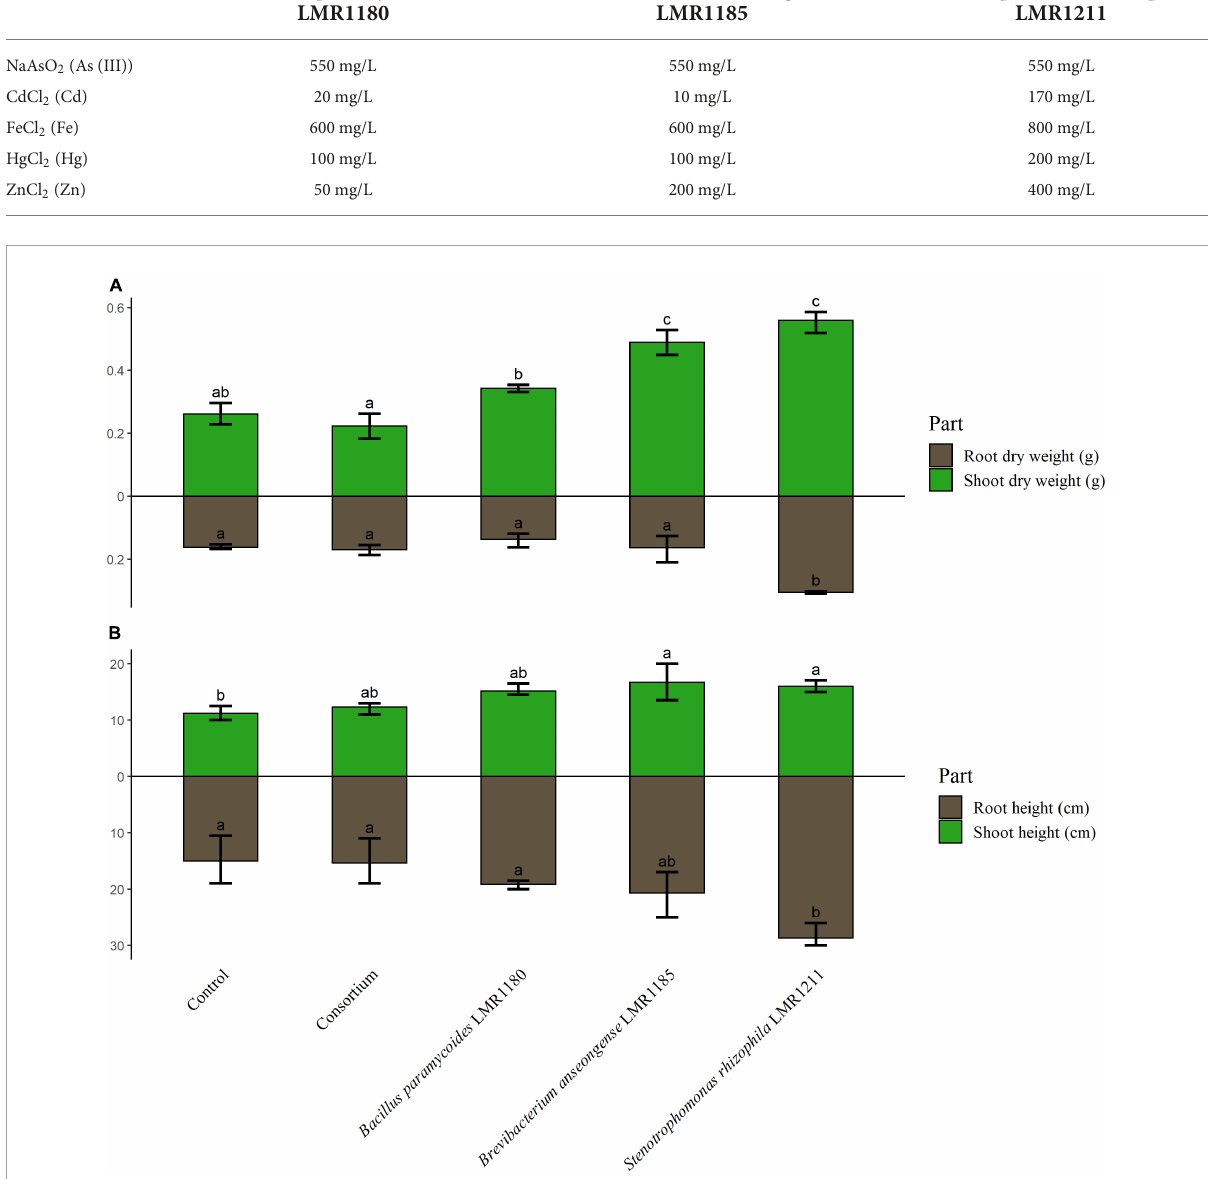
FIGURE5 The measurement of control and inoculated Lupinus albus plants using the three selected strains ( Bacillus paramycoides LMR1180, Brevibacterium anseongense LMR1185, and Stenotrophomonas rhizophila LMR1211). The dry weight of shoot and root parts (A) is represented in g, and the height of shoot and root parts (B) in cm after 90 days under greenhouse conditions. The letters (a, b, and c) present the compact display letters (CDL). Values in each bar followed by the same letter are not significantly different at 0.05%